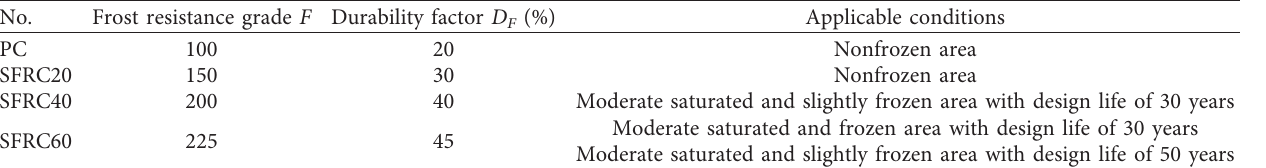
Table 4: Frost durability factors and applicable condition of the SFRC.